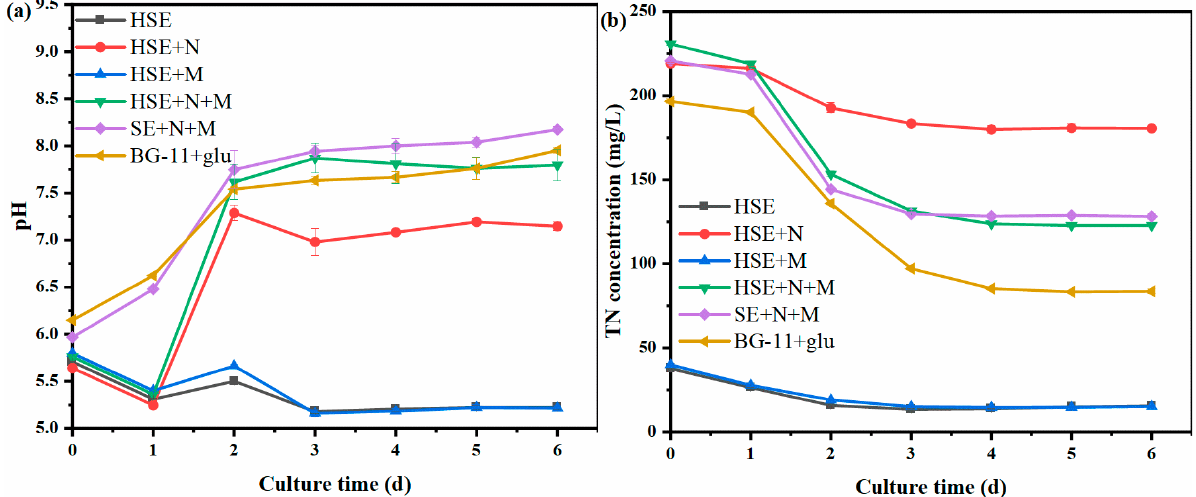
Figure 2. The change curves of pH ( a ) and the total nitrogen concentration ( b ) during the culture of heterotrophic C. vulgaris .